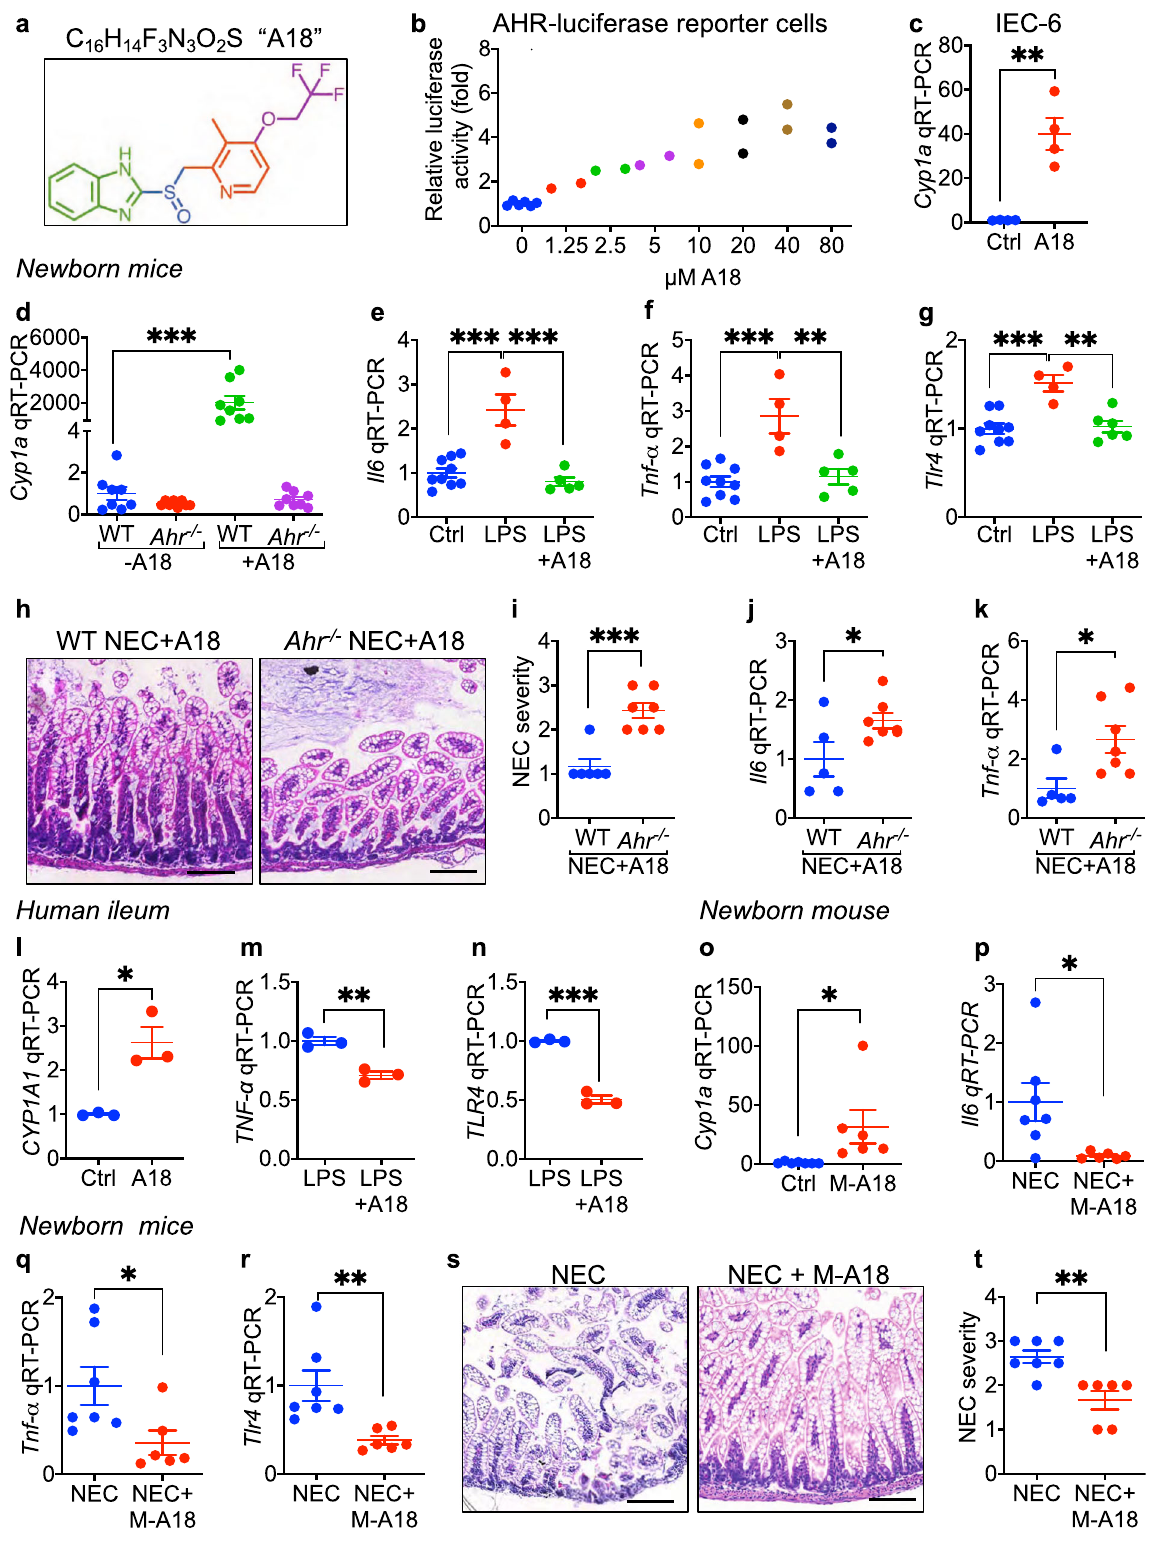
severity of this disease. The mechanism by which AHR activation in the intestinal epithelium attenuates NEC severity involves a reduction in signaling and expression of the innate immune receptor TLR4, whose expression is elevated in the premature bowel as compared with the full term bowel 5,9 , and whose acti- vation on the intestinal epithelium we have shown to be